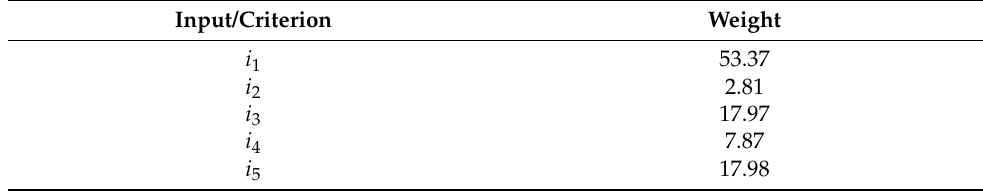
Table 6. Input weights for z = 19.